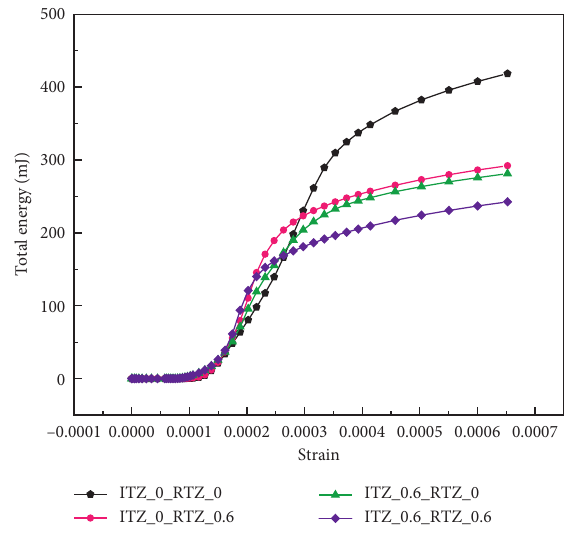
Figure 10: Energy-strain curves of the A-M ITZs and R-M ITZs existence